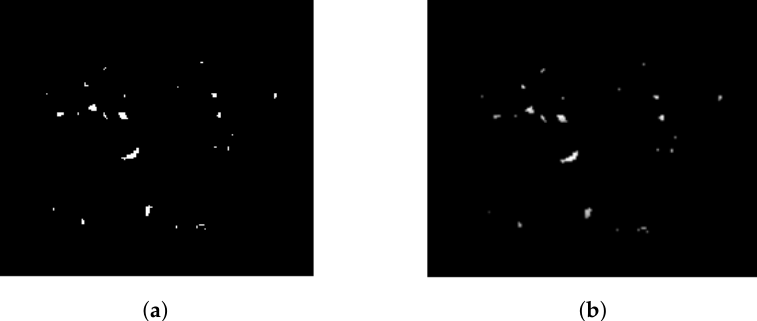
Figure 6. ( a ) Elimination of blobs containing one or two pixels from the probability image generated in Section 2.2.2 (see Figure 5g); and ( b ) final probability image, for example case ( 1_1076_463 ), after discarding all blobs from 1 cm 2 pixel block whilst objects inside the block were less than 3. In this example, all the 1 cm 2 pixel blocks contained more than three blobs so no object elimination was